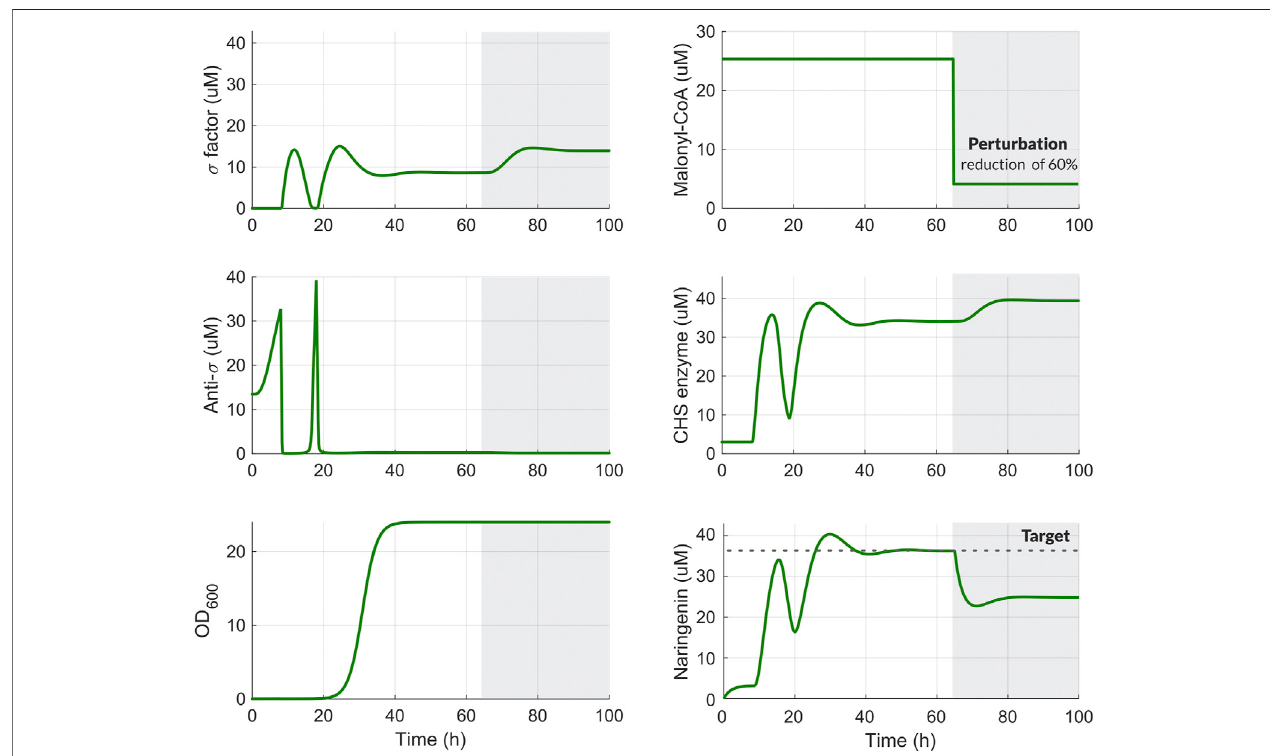
FIGURE 4 | Temporal response of the system including the dynamic pathway regulation scheme for the naringenin pathway. Time-course variation in the biocontroller species ( σ and Anti- σ ), malonyl-CoA secondary substrate, CHS enzyme, naringenin, and cellular growth (OD) before (white background) and after 60% reduction in malonyl-CoA availability (grey background). After the perturbation, the amount of naringenin begins to decline until it recovers steadily thank to the transient increase in the amount of the CHS enzyme. This increase is generated by the activation of factor when the perturbation